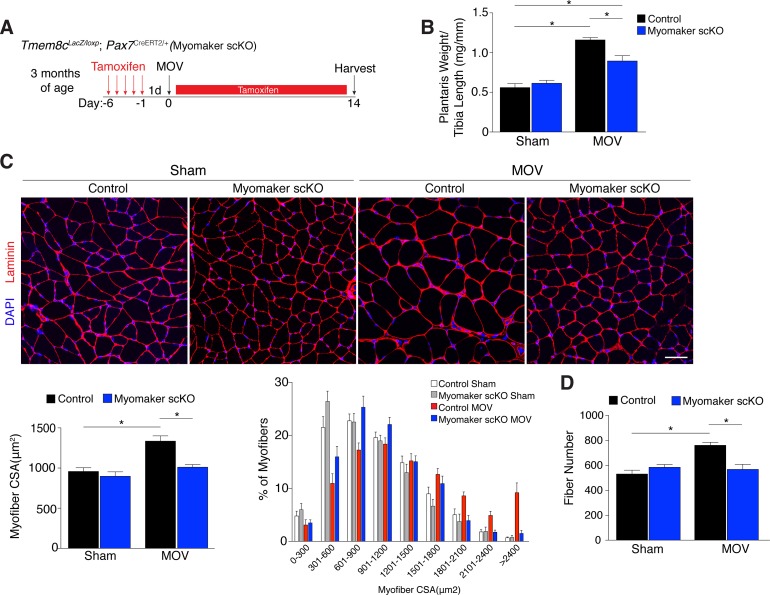
Genetic loss of myomaker in MPs results in an absence of muscle hypertrophy.(A) Schematic showing timing of tamoxifen treatment by intraperitoneal (IP) injections, MOV, and tissue harvest. Tamoxifen was maintained after MOV through IP injections every other day. (B) Plantaris weight normalized to tibia length indicates a dramatic increase in size in control mice, which is blunted in myomaker scKO mice (n = 7–13 mice). (C) Representative laminin-stained plantaris sections shows an increase in myofiber size after muscle overload in control mice but not in myomaker scKO mice. Quantification of cross-sectional area (CSA) of myofibers at the plantaris mid-belly reveals a significant inhibition of myofiber hypertrophy with satellite cell ablation of myomaker (n = 3200–5,400 myofibers from 7–11 independent mice). Relative frequency of myofiber sizes in the various groups of mice demonstrates that control muscle exhibits a greater percentage of larger fibers after MOV. (D) Fiber number was quantitated at the mid-belly of the plantaris, and reveals a significant inhibition of new fiber formation in plantaris muscle when myomaker was ablated in satellite cells (n = 7–11 mice). Data are represented as mean ± SEM, *p<0.05. Scale bar: 50 μm.